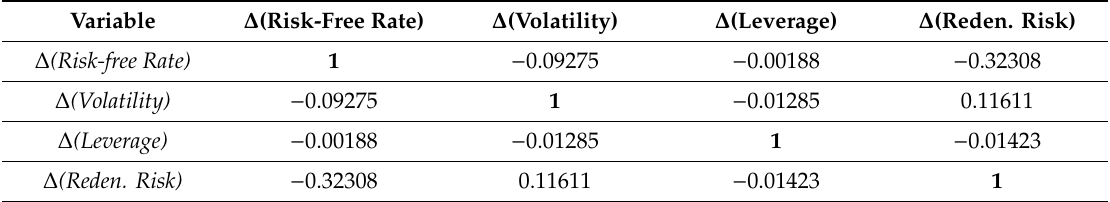
Table A7. Correlation matrix: period March 2018–September 2018 (96